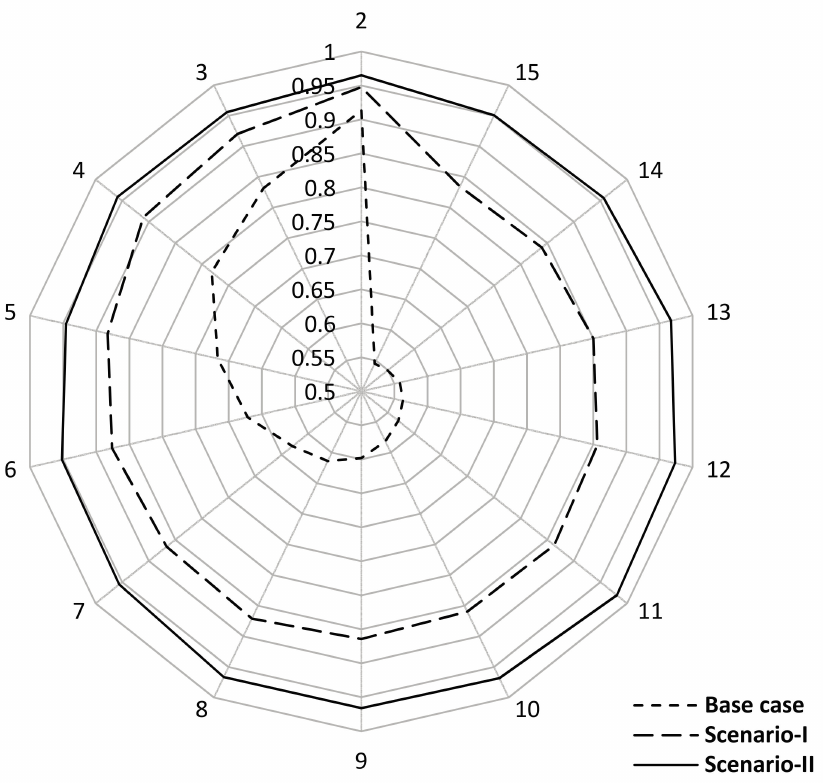
Figure 27. The impact of compensated devices on voltage stability profile for 15-bus of MEDN with PV and